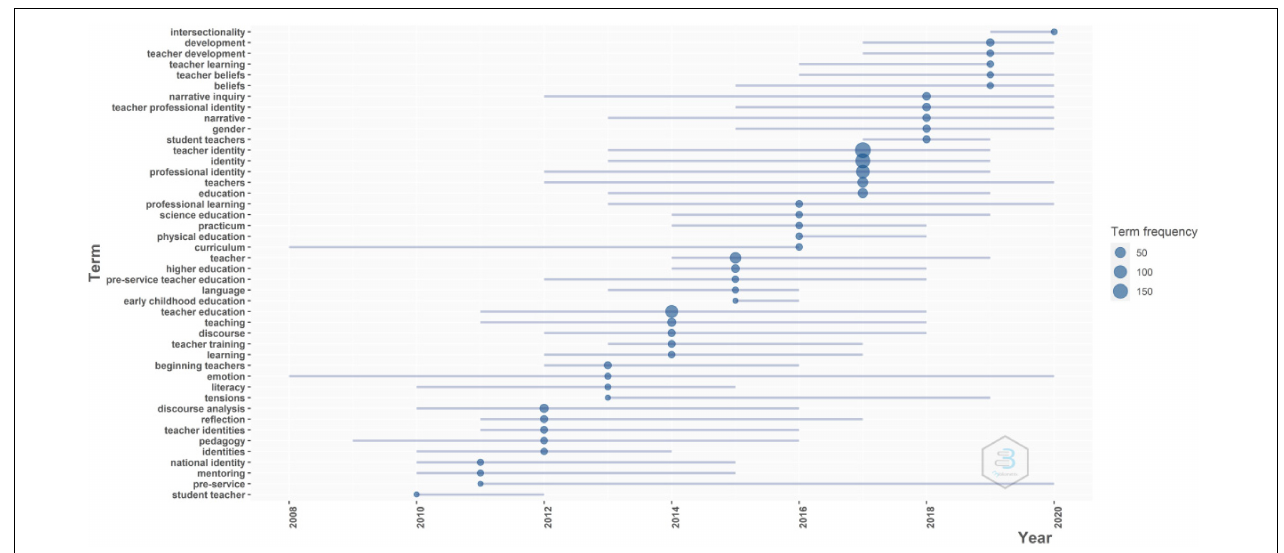
FIGURE 12 | Trend Topics by author’s